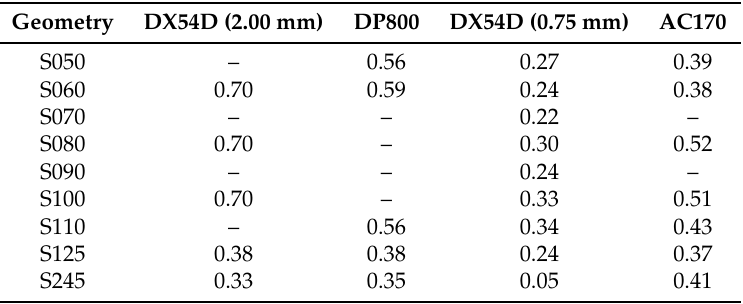
Table 2. Inter-Rater-Reliability in terms of Fleiss-Kappa statistics.